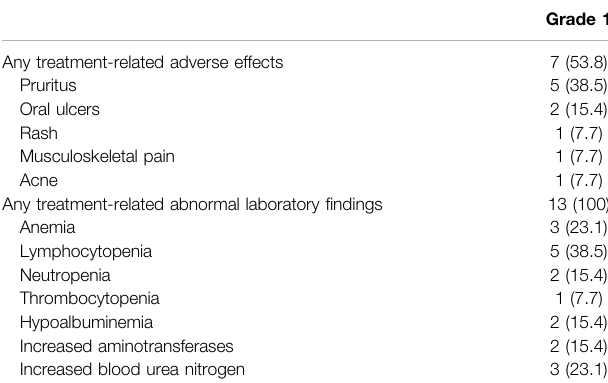
TABLE 4 | Toxicity pro fi